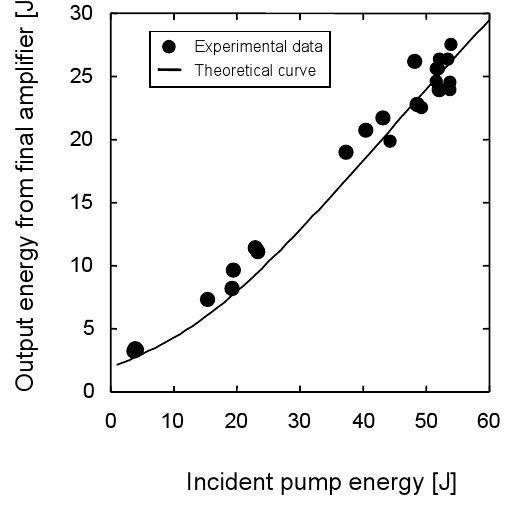
Figure 5. Measured output energy from Ti:sapphire final amplifier versus pump